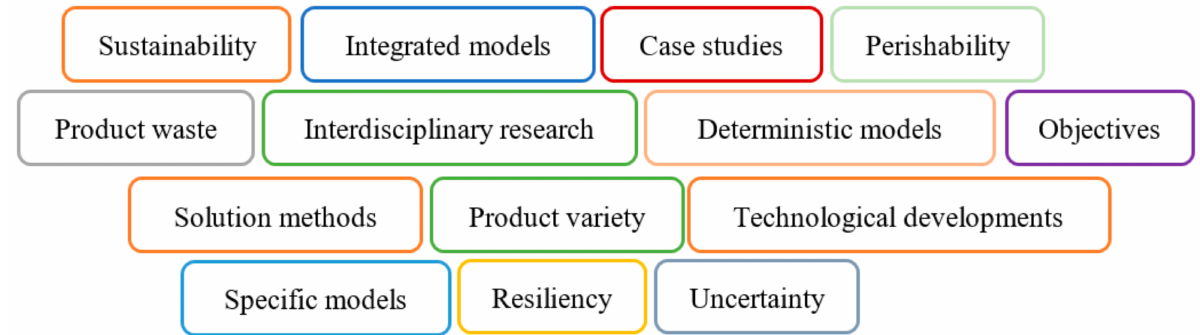
Figure 7. Topics